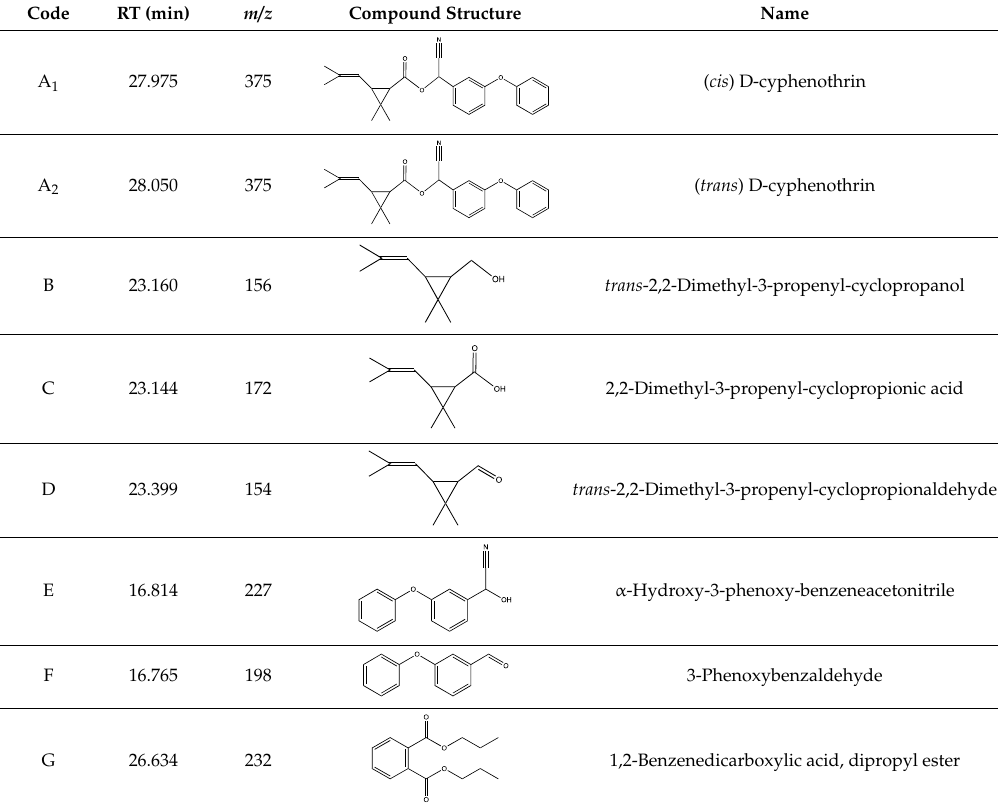
Table 5. Chromatographic properties of D-cyphenothrin metabolites during degradation with Staphylococcus succinus HLJ-10.